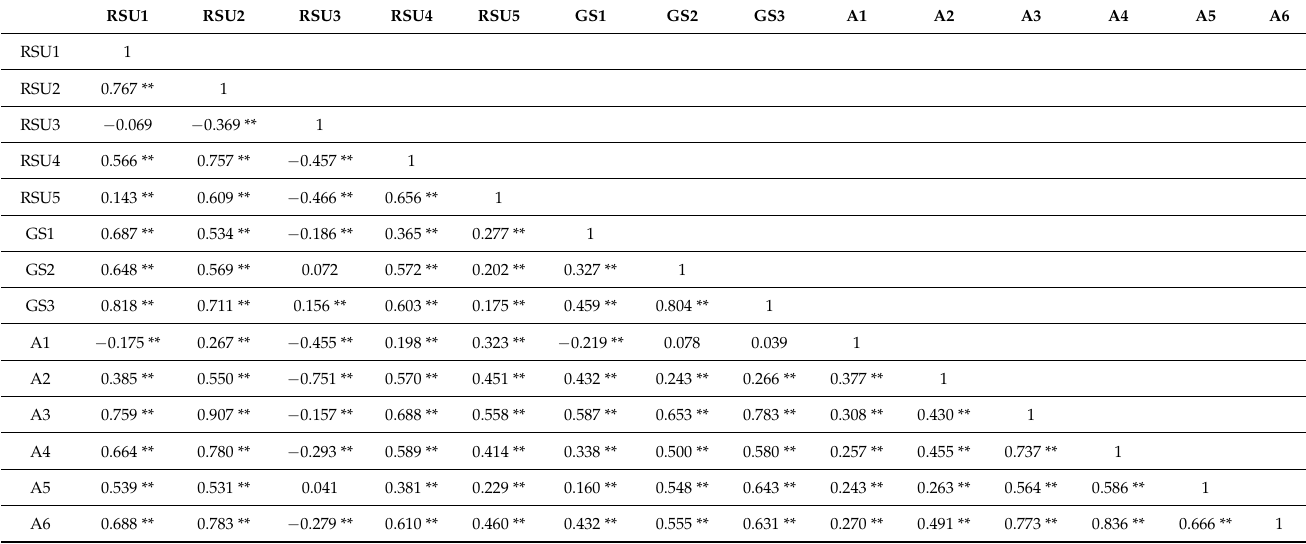
Table 5. Pearson bivariate correlation matrix.